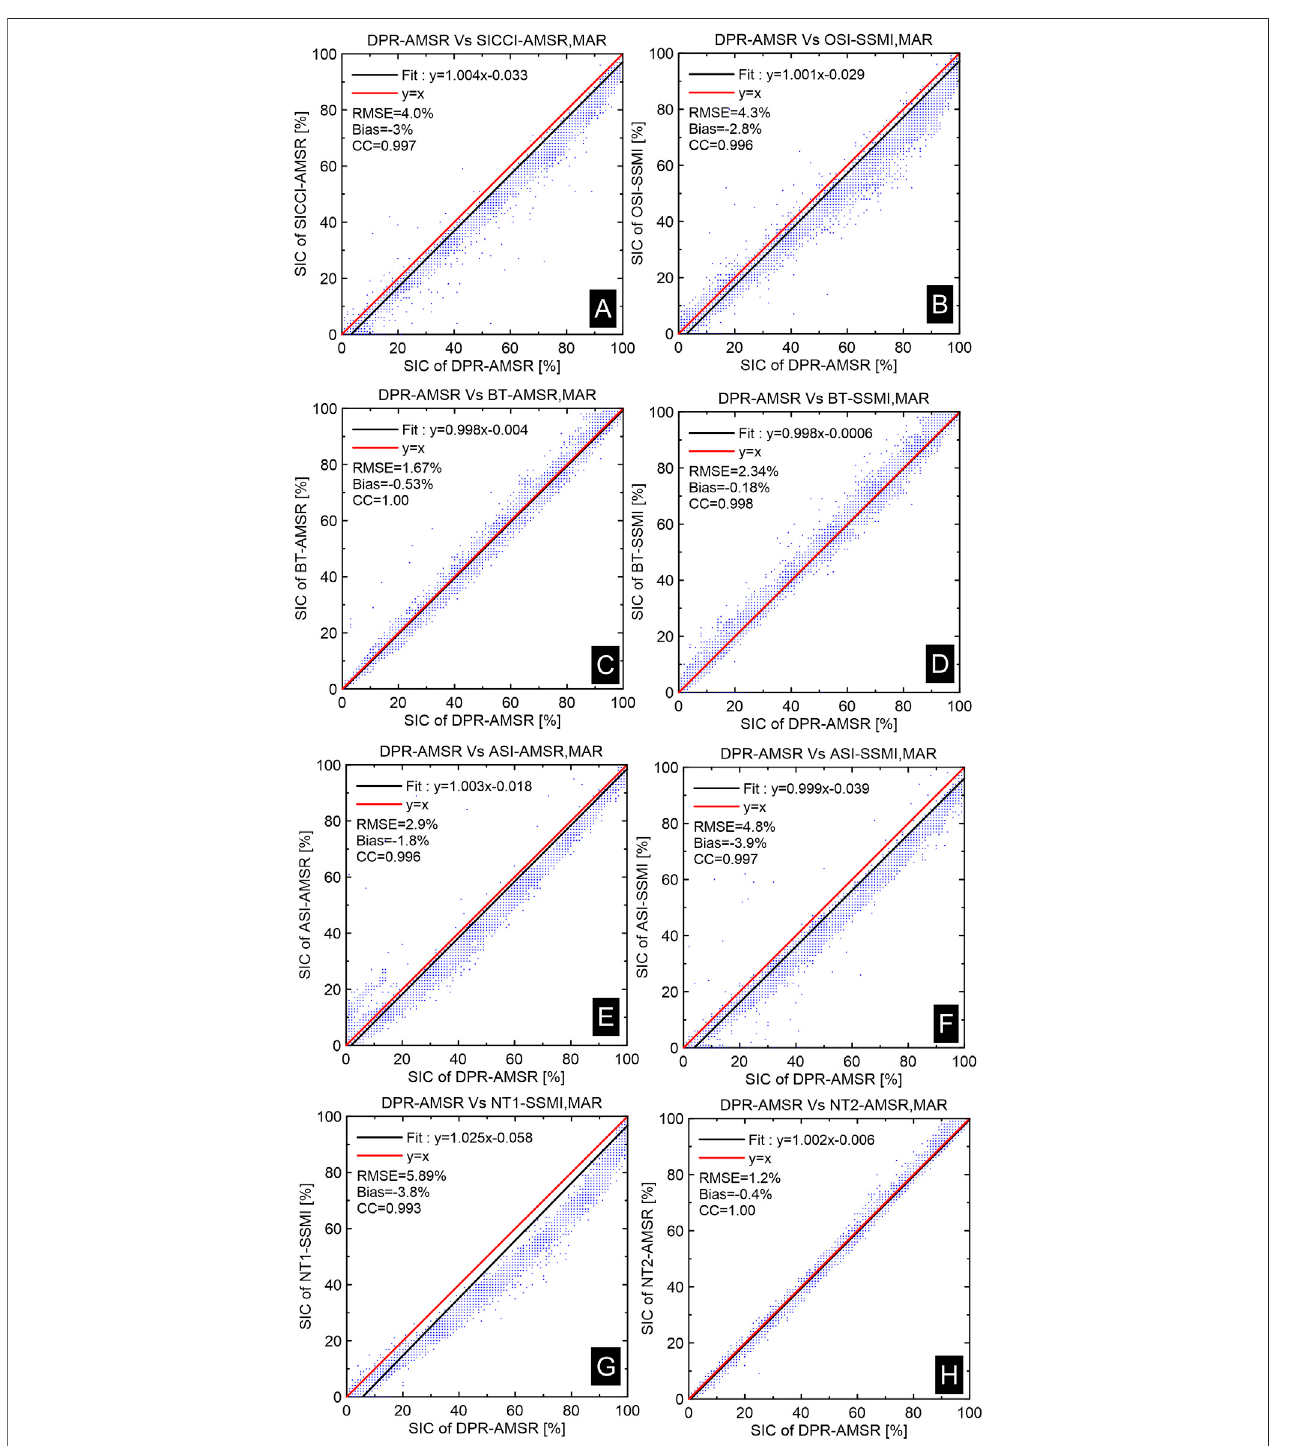
FIGURE 8 | Scatterplots of ensemble mean multi-annual average monthly sea ice concentration of DPR-AMSR and other eight sea ice concentration data sets in March (2002 – 2015): SICCI-AMSR (A) , OSI-SSMI (B) , BT-AMSR (C) , BT-SSMI (D) , ASI-AMSR (E) , ASI-SSMI (F) , NT1-SSMI (G) , and NT2-AMSR (H) . Red solid lines representtheequality y = x .Blacksolidlinesrepresentlinear fifi tsofdatapoints. Linearequations, correlation coef fifi cients (CC), and biases androotmeansquare errors (RMSE) are also presented.